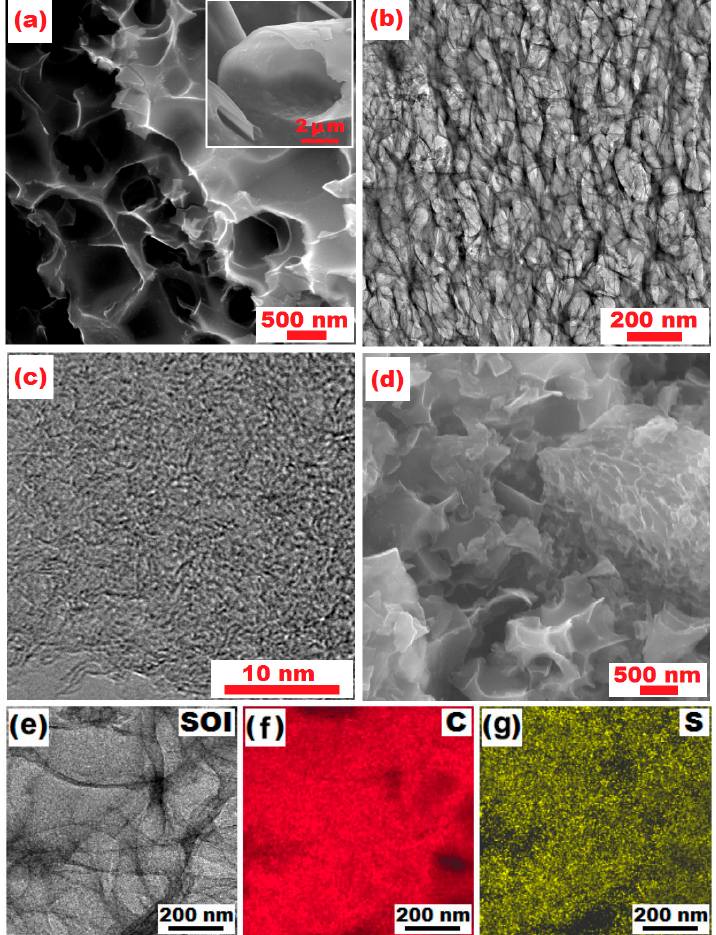
Figure 4. ( a ) SEM image of HPC, inset: SEM image of carbon microtube derived from catkin without KOH activation; ( b , c ) TEM images of HPC at different magnifications; ( d ) SEM image of S/HPC composite; ( e – g ) TEM image of S/HPC sample and EDS mapping showing distribution of C and S.